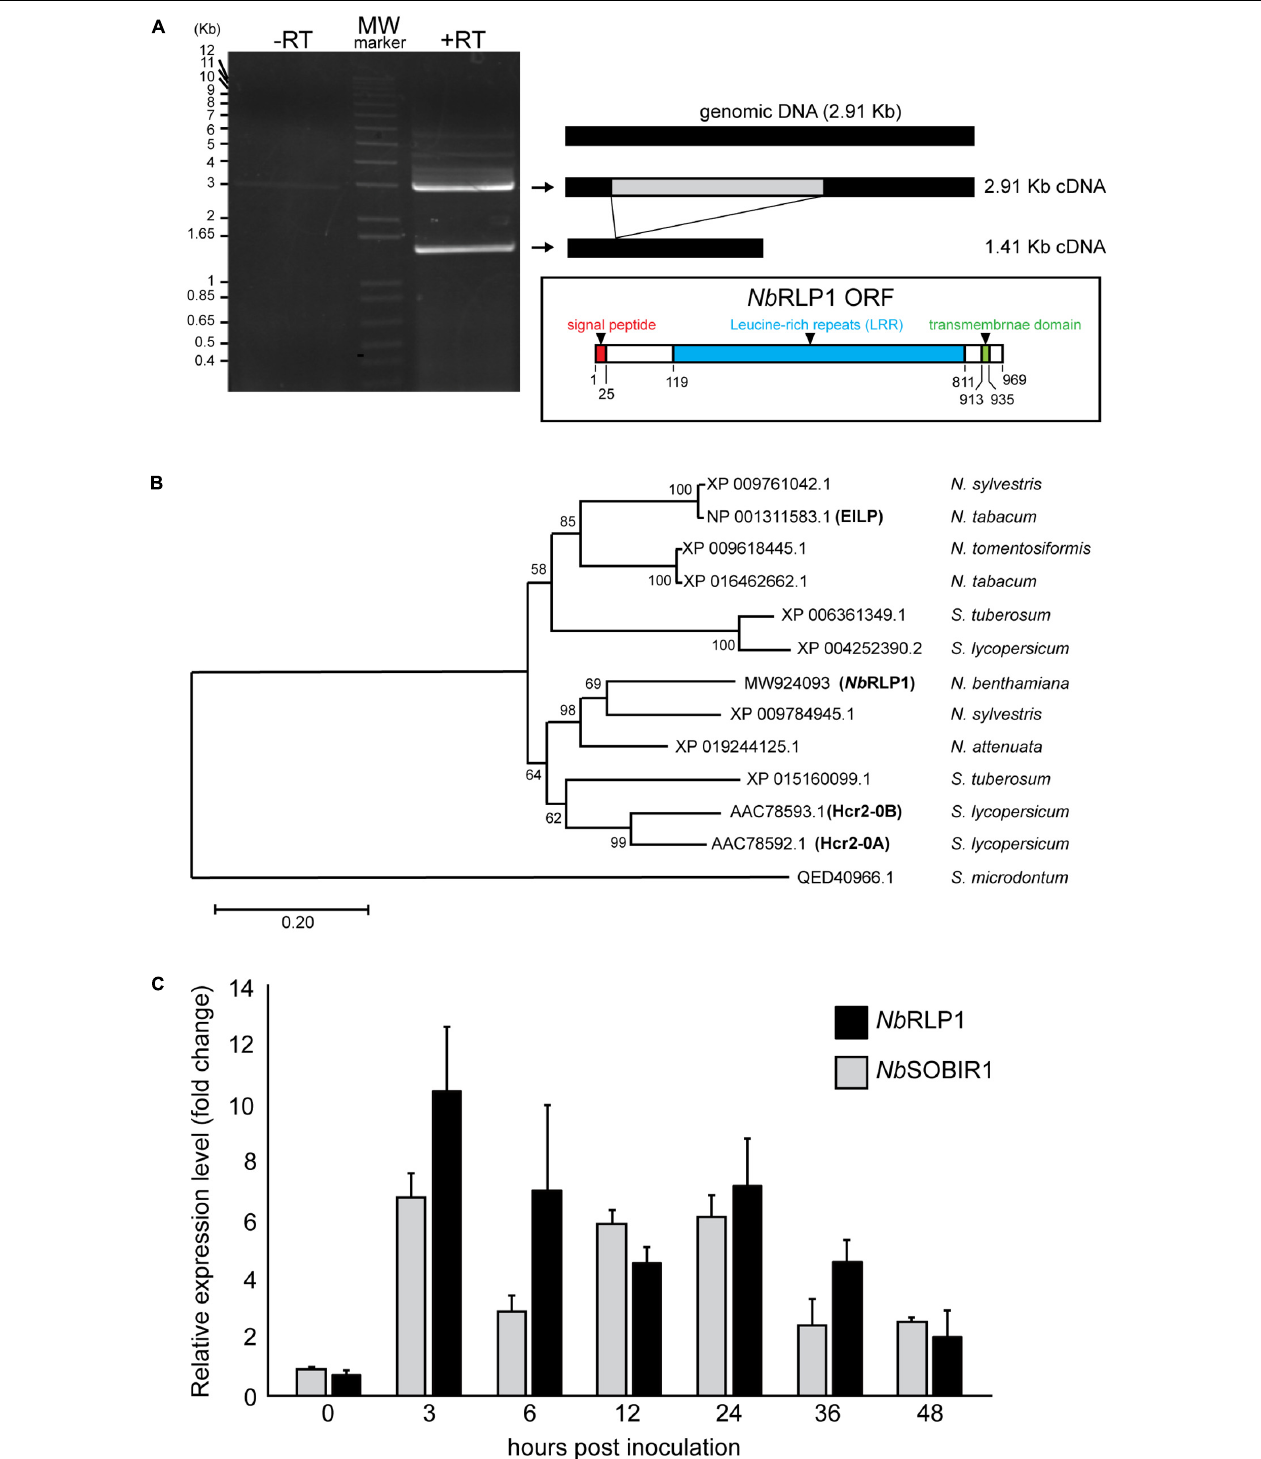
FIGURE 1 | The expression of Nb RLP1 is induced in response to infection by Phytophthora parasitica . (A) Nb RLP1 is alternatively spliced. Reverse transcriptase-polymerase chain reaction (RT-PCR) gave rise to two amplified products with respective length of 1.41 and 2.91 Kb (+ RT), which were not detected in the absence of reverse transcriptase (-RT). The 2.91-Kb gene, named NbRLP1 (MW924093) encodes a 969-amino acid protein containing a signal peptide (predicted by SignalP), an LRR domain (predicted by InterPro), and a transmembrane domain (predicted by TMHMM) as illustrated in the inset. (B)